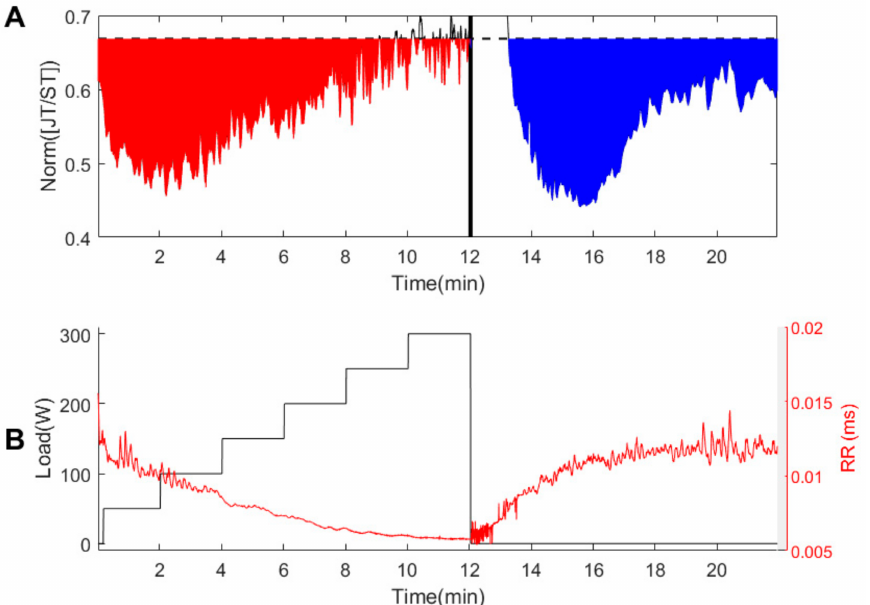
Figure 7. The dynamics of the JT/ST relationship during the load and recovery processes for person #6. The x -axis in parts ( A , B ) represents the time (measured in minutes) from the beginning of the cycle ergometry exercise. The left y-axis in part ( B ) represents the power of the load in Watts. The right y-axis in part ( B ) represents the variation of the RR interval in ms. The algebraic JT/ST relationship is represented by the thin dashed black line in part A. The thick black solid vertical line in part A marks the end of the